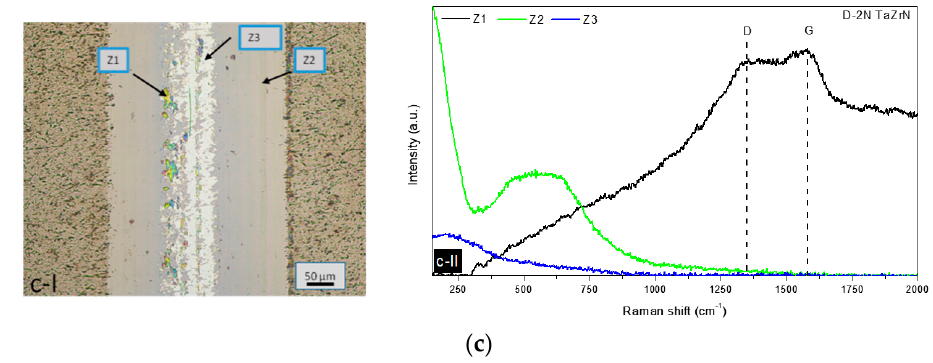
Figure 14. Results obtained in the tribological tests under corrosive conditions. ( a-I – c-I ) shows optical images of wear tracks from the tests at 0.5, 1, and 2 N, respectively; ( a-II – c-II ) (for loads of 0.5, 1, and 2 N) presents the Raman spectra of each point, labeled Z1 to Z4.